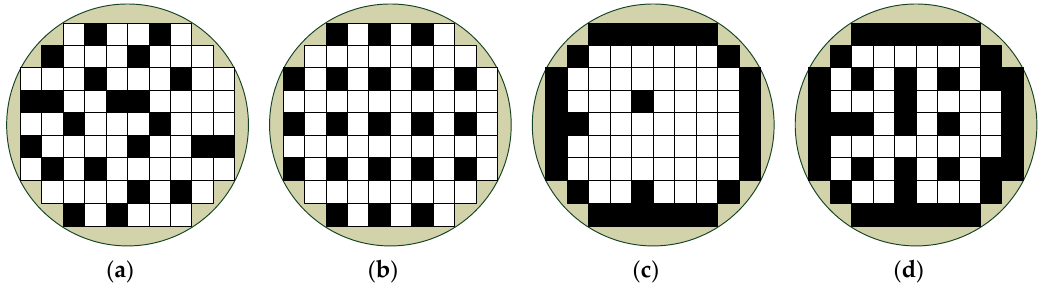
Figure 2. Wafer defects: ( a ) random defect, ( b ) repeatable defect, ( c ) systematic defect, and ( d ) combinational defect.